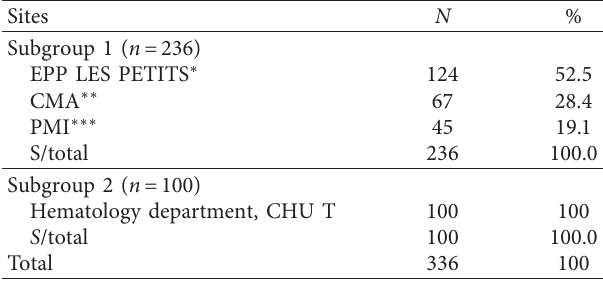
Table 1: Distribution of the study population according to the sampling site.